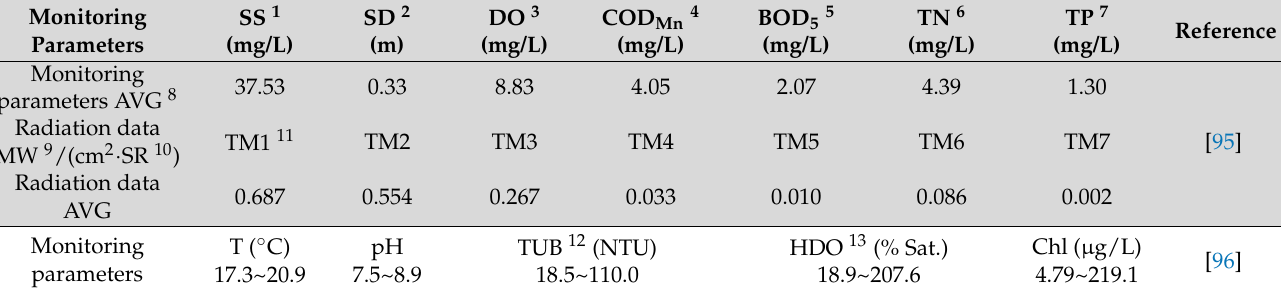
Table 3. The remote sensing parameters and TM radiation of lake data.